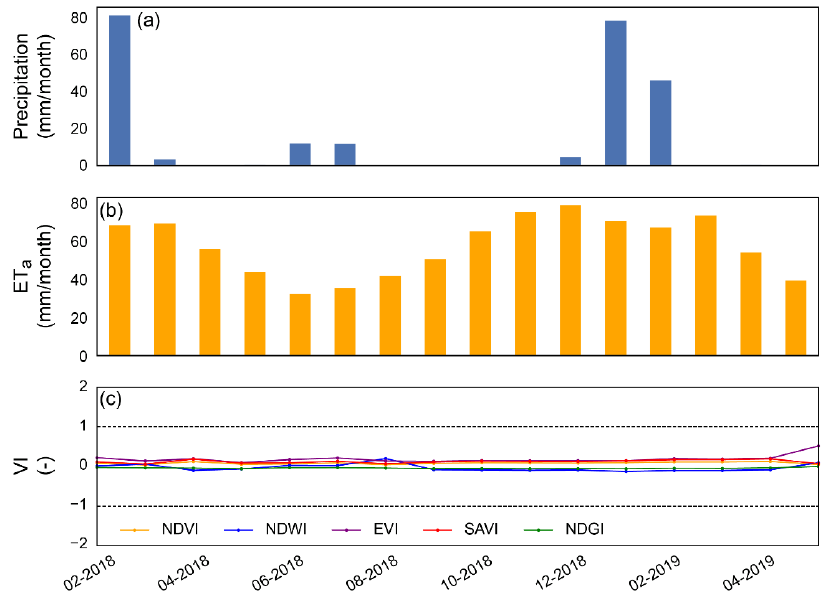
Figure 7. Temporal evolution of monthly precipitation ( a ), monthly ET a ( b ), and monthly VIs ( c ) in CH-AT1.